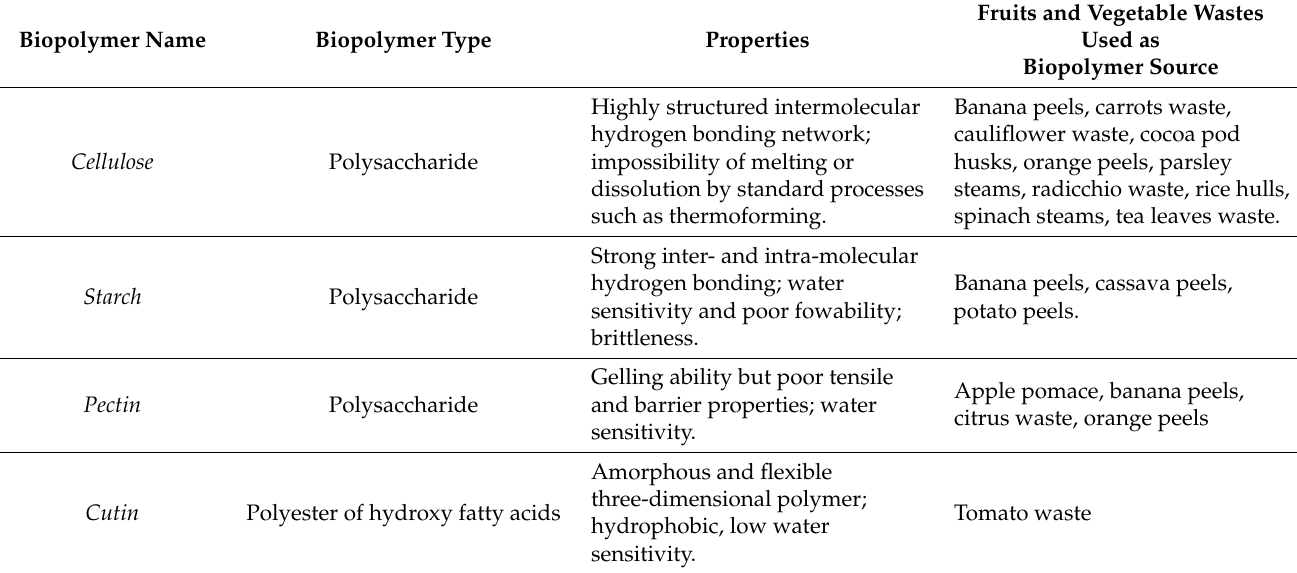
Table 1. Properties associated with the main biopolymers extracted from fruits and vegetable wastes for bioplastics